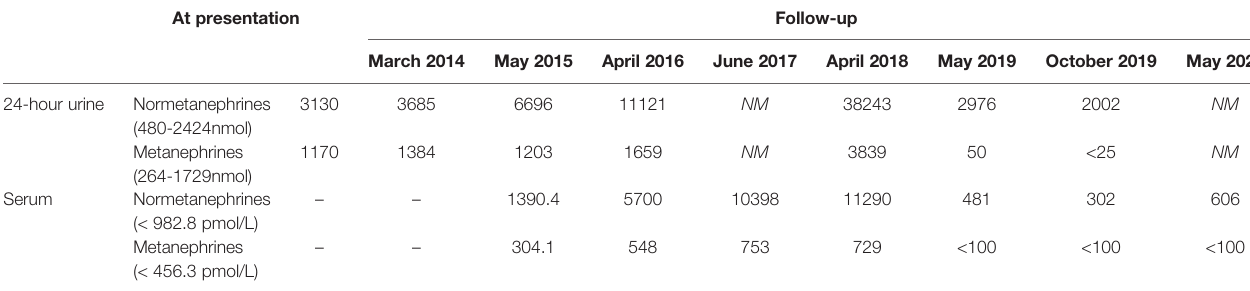
TABLE 3 | Serum and 24-hour urinary metanephrines (reference range), by year of patient 3. At presentation